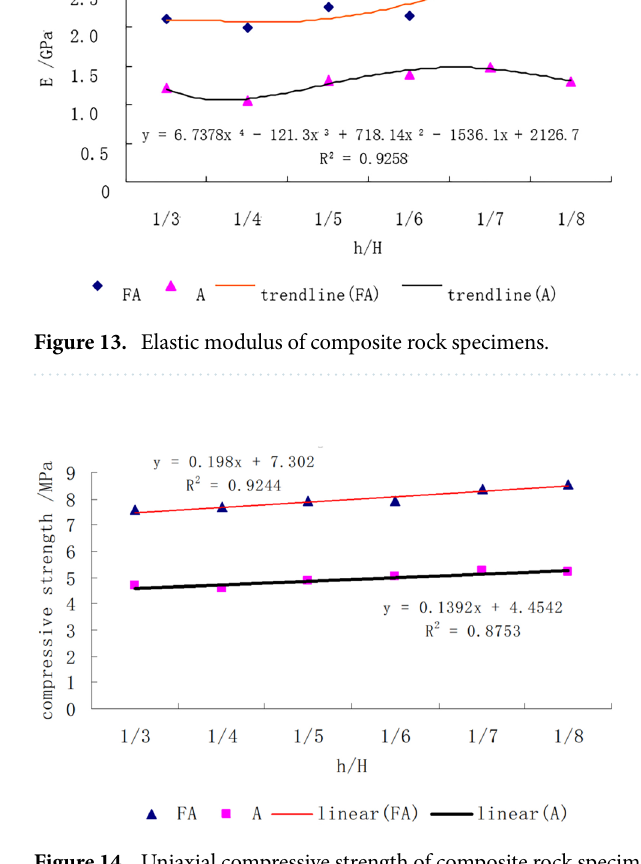
Figure 14. Uniaxial compressive strength of composite rock specimens.